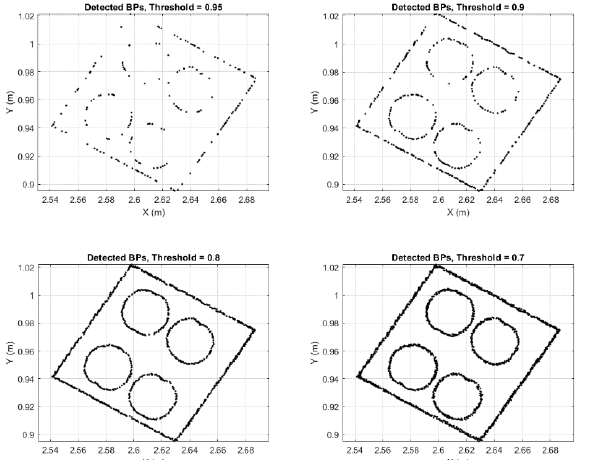
Figure 4 : Boundary point differences for points-in-circle, ,